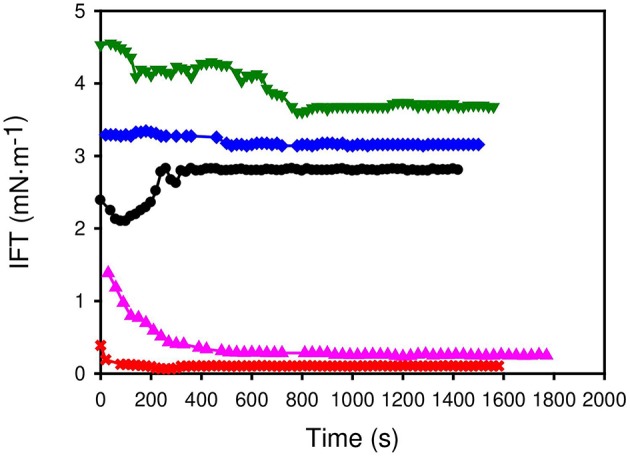
Dynamic interfacial tension between aqueous solutions of the surfactants (concentration is twice the cmc) and crude oil. • Na [ONS] ,▴[C1Pyr] [ONS] ,×[C1C6Im] [ONS] ,▾[C2Py] [ONS] ,♦[C4Py] [ONS].